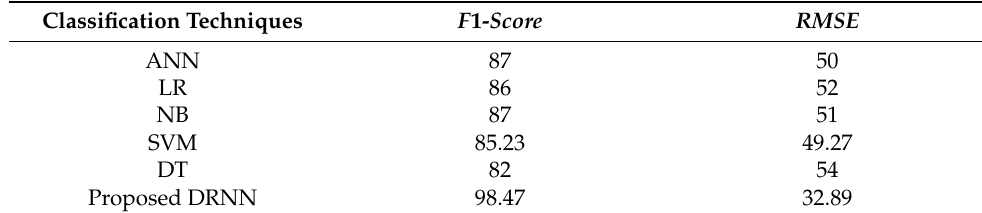
Table 2. F1-scores and RMSE measures of existing and proposed techniques.